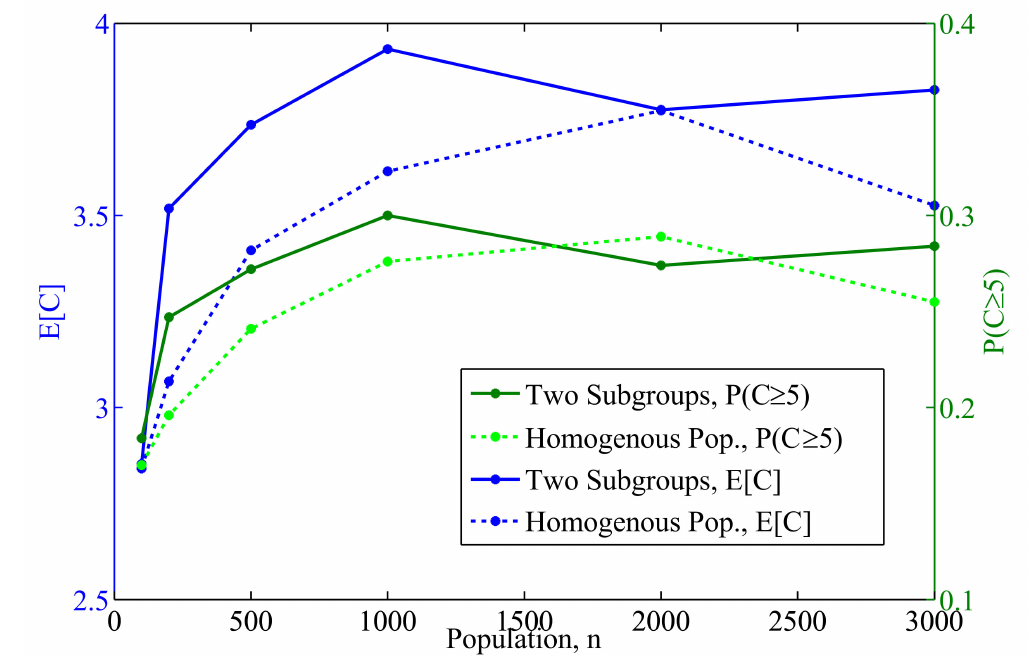
Figure 1. The average number of infected cases (E[ C ], left , blue ) and the probability of a large outbreak (P[ C ≥ 5], right , green ) as we varied the size of the population. The dashed lines are for the case of a homogenous population while the solid lines are for the case where the population was divided into two equal-sized subgroups. There were 1000 replications and the standard error was less than 0.11 for E[ C ] and 0.02 for P[ C ≥